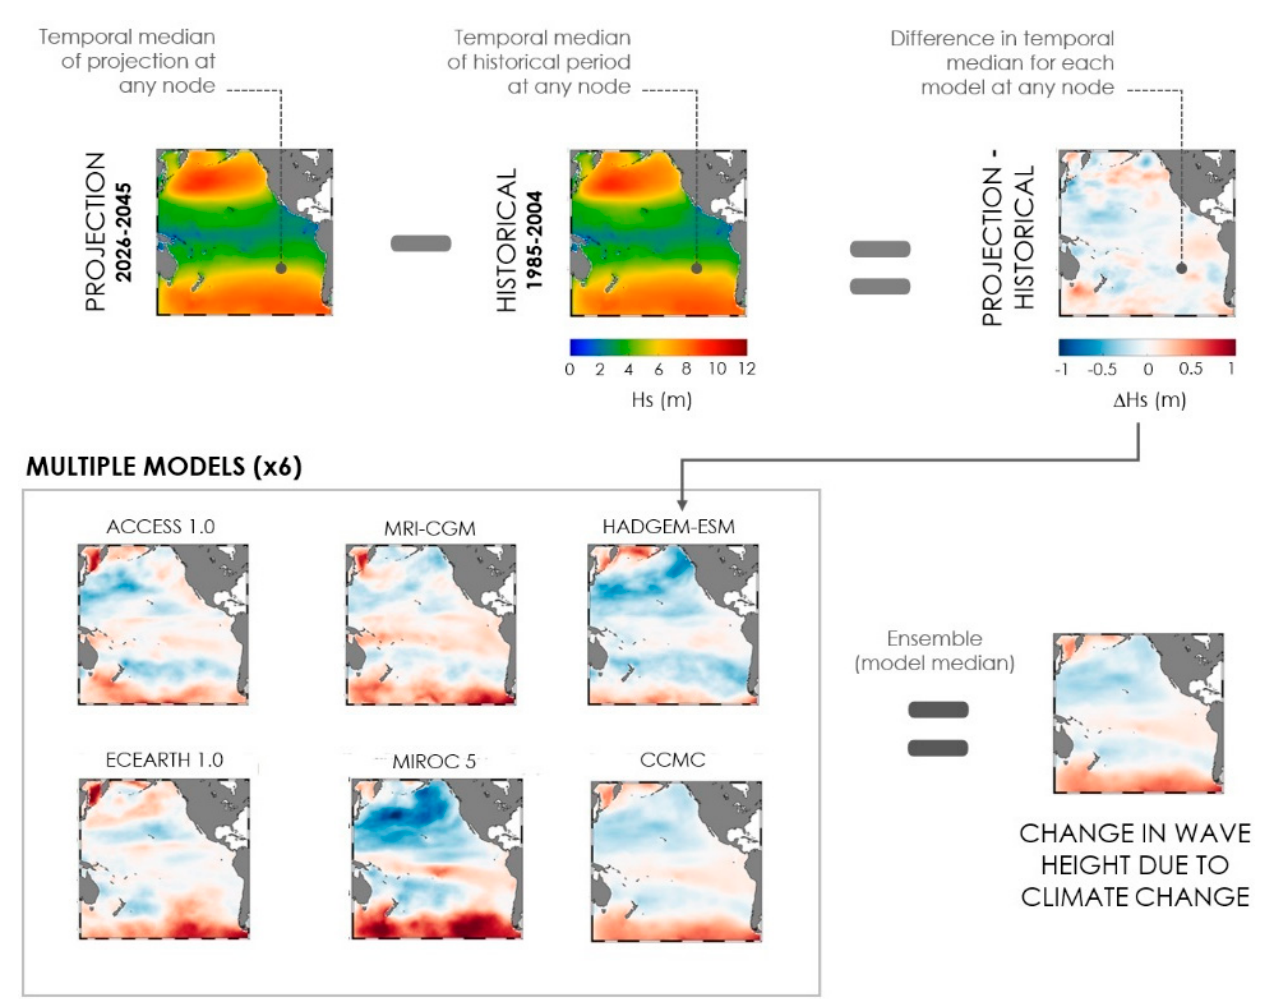
Figure 1. Conceptual model to compute changes in wave climate between the projection (2026–2045) with respect to the historical period (1985–2004). The top panel shows the computation of the temporal median for the historical period and projection and the difference between them in the modeling domain for one GCM (HADGEM-ESM as an example). The bottom panel shows the differences for all six models from which the median difference is computed and attributed to climate change. In this example, fields of significant wave heights are shown in the Pacific Ocean.